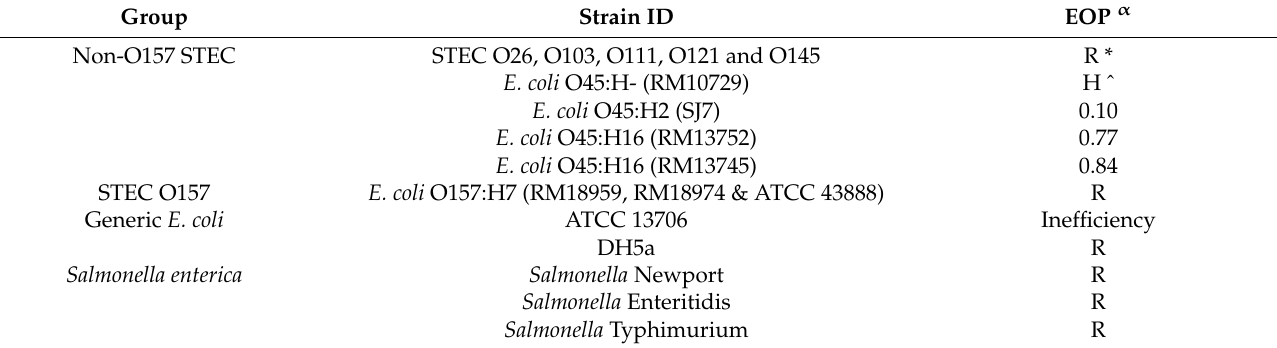
Table 2. Host range and efficiency of plating of phage Ro45lw against various serogroups of Shiga- toxin-producing E. coli and Salmonella enterica strains.